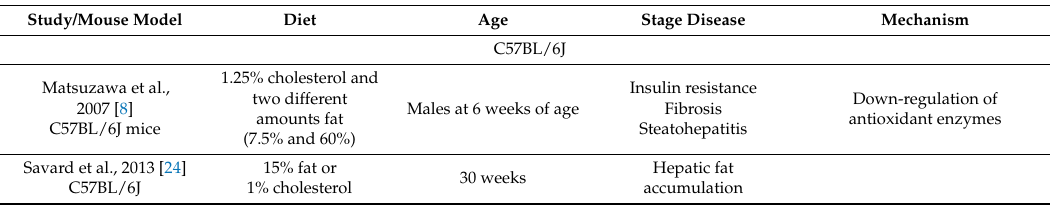
Table 2. Impact of dietary cholesterol in mouse models of non-alcoholic fatty liver disease (NAFLD) and non-alcoholic